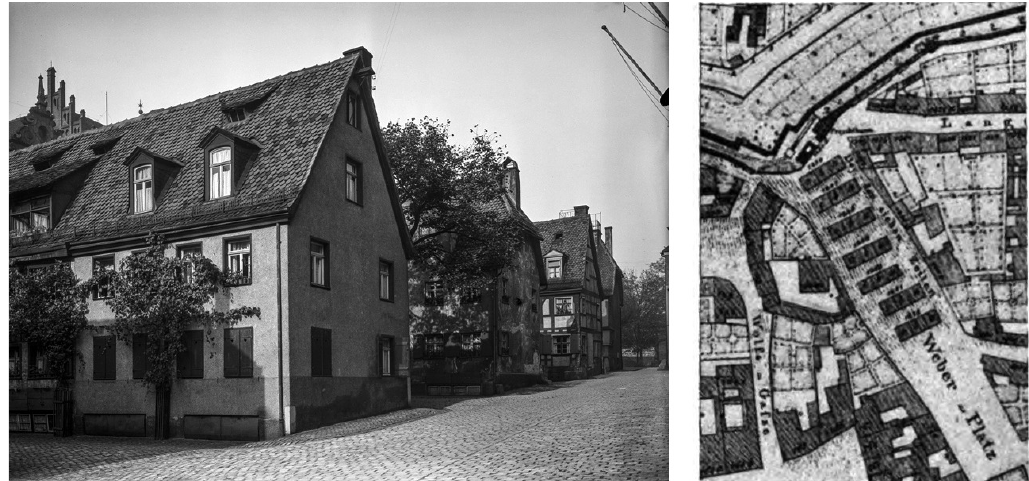
Figure 3. Left: Photograph of Nuremberg’s Seven Rows. Right: Map highlighting the Seven Rows. Sources: “Sieben Zeilen” [Seven Rows] (1918, © Bildarchiv Foto Marburg) and Kuhn (1921, p. 102). Urban Planning, 2022, Volume 7, Issue 1, Pages